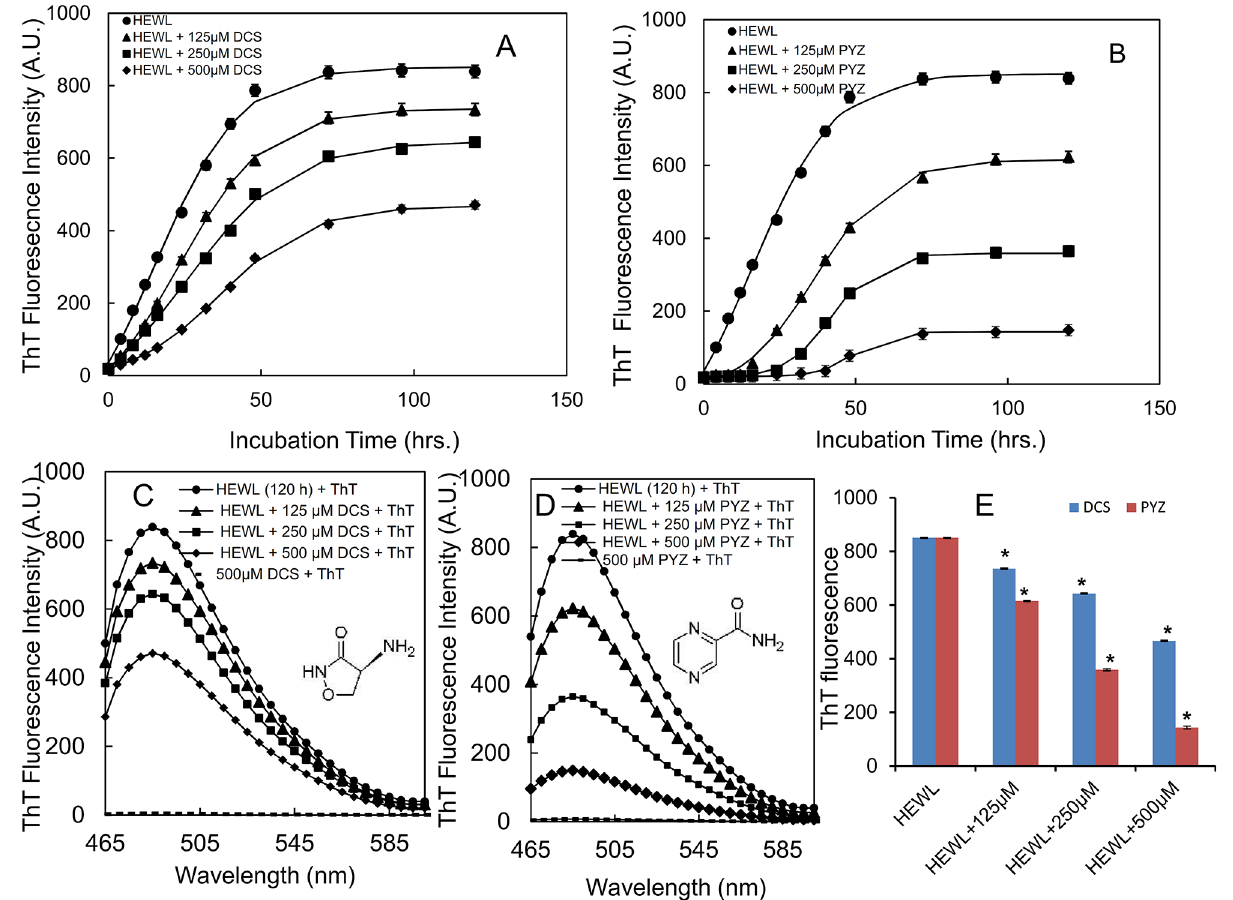
Fig 2. ThT fluorescence kinetics measurements of HEWL. (A) when incubated at 65°C over a period of 120 h in absence and in presence of 125, 250 and 500 μ M of DCS (B) when incubated at 65°C over a period of 120 h in absence and in presence of 125, 250 and 500 μ M of PYZ. ThT fluorescence spectra of HEWL (C) after incubated at 65°C for 120 h in absence and in presence of 125, 250 and 500 μ M of DCS (D) after incubated at 65°C for 120 h in absence and in presence of 125, 250 and 500 μ M of PYZ. (E) ThT fluorescence intensity of HEWL (120h) in presence of 125, 250 and 500 μ M each of DCS and PYZ. * Statistically different from the control group, p (cid:6) 0.01 and # statistically different from the HEWL, p (cid:6) 0.01. The 500 μ M each of PYZ and DCS were taken as control.